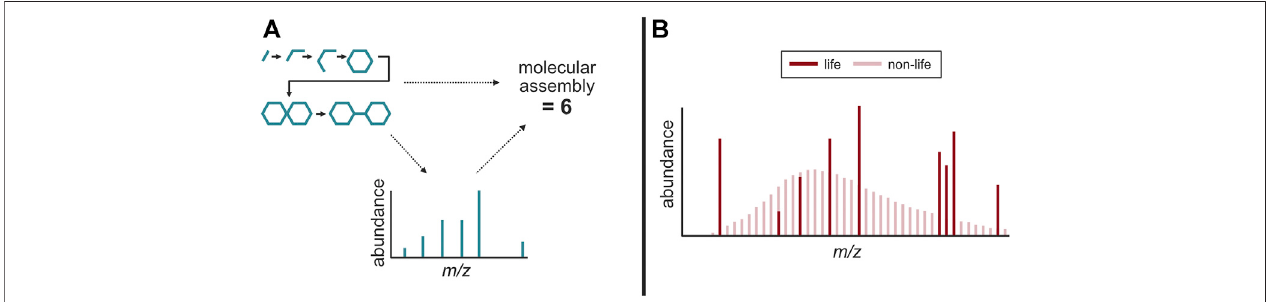
FIGURE 3| Possible agnostic biosignatures detectable using massspectrometry. (A) Molecular assembly measurements of amolecule,correlated to the number of fragments in its mass spectra. (B) The uniform distribution of compounds found in non-life versus the discrete distribution of compounds found in life, potentially the result of the Lego principle. Adapted from McKay